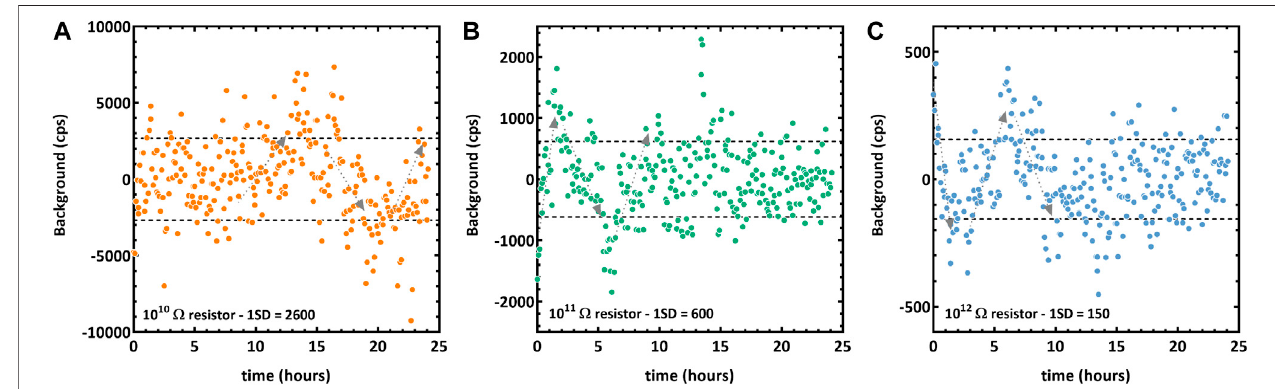
FIGURE 1 | Long-term stability of L ′ 2, H1 (multicollection) and FC2 (monocollection) FCs backgrounds equipped with 10 10 Ω , 10 11 Ω , and 10 12 Ω preampli fi ers, respectively. Backgrounds are measured for 90 s every 5 min. Dotted lines correspond to the standard deviation (1SD): ∼ 2,600 cps on L ′ 2, ∼ 600 cps on H1 and ∼ 150 cps on FC2. Dotted gray arrows display thermal drifts of FC preampli fi ers due to small room temperature